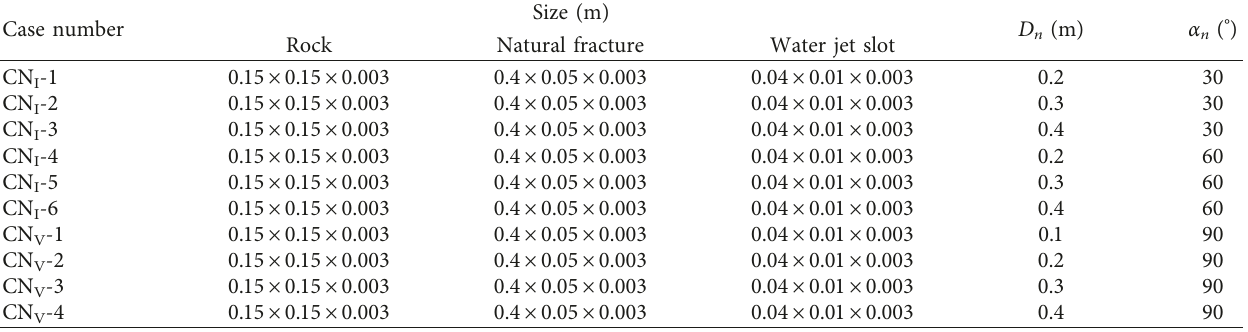
Table 1: Numerical simulation cases.